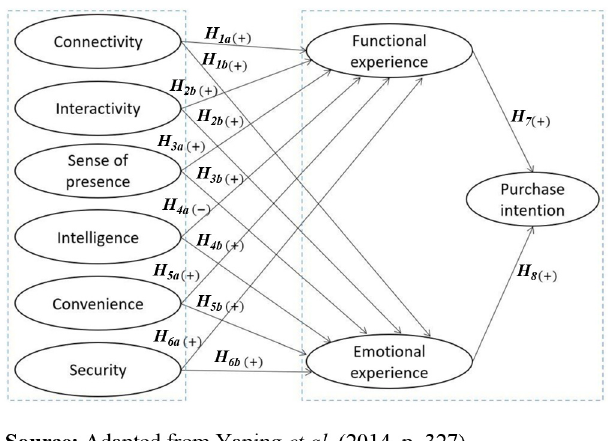
Figure 1. Hypotheses of the proposed model with the additional